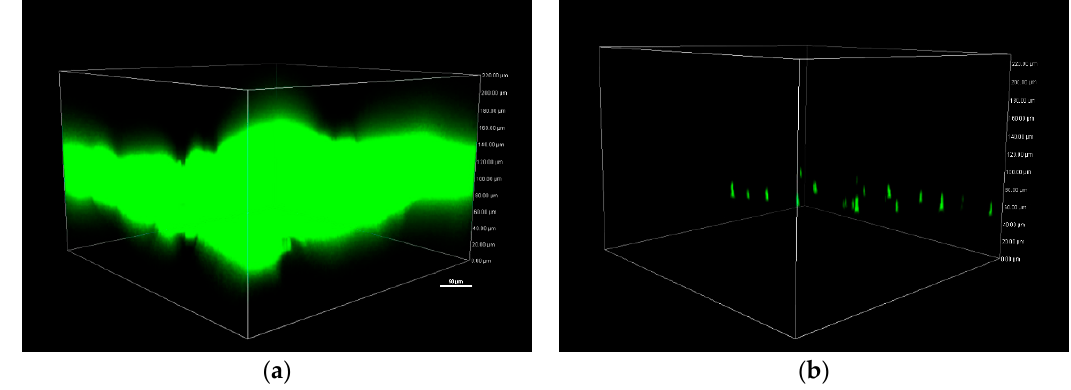
Figure 8. 3D-generated confocal laser scanning microscopy (CLSM) images of biofilm formation on ( a ) cellulose and ( b ) cellulose-CdTeQD films in the presence of S. aureus GFP AH133.